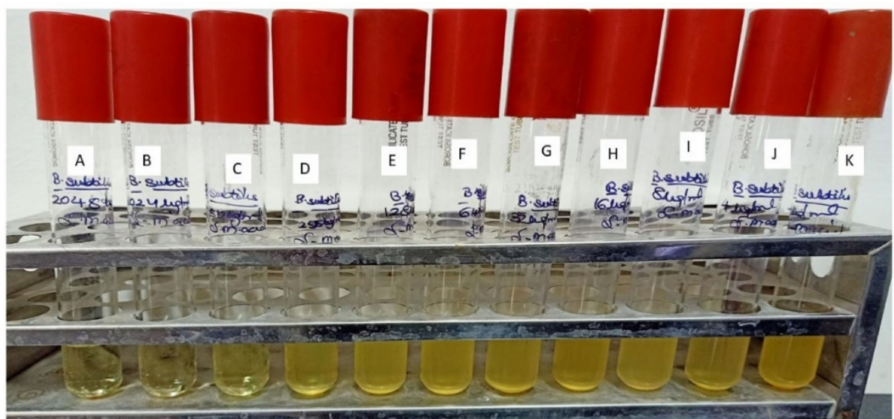
Figure 12. Minimum inhibitory concentration of Alpha dimorphecolic acid against Bacillus subtilis (MTCC 441) Muller Hinton agar broth tubes A to K dilution range from 1024 to 1 µ gmL − 1 . A—